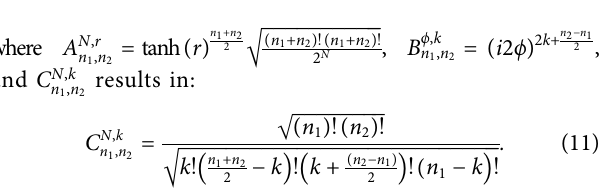
(cid:5)(cid:5)(cid:5)(cid:5) (cid:5)(cid:5)(cid:5)(cid:5) ( x , y ) ψ . The numerical results con fi rm creation of N / 2 vortices for N total LG